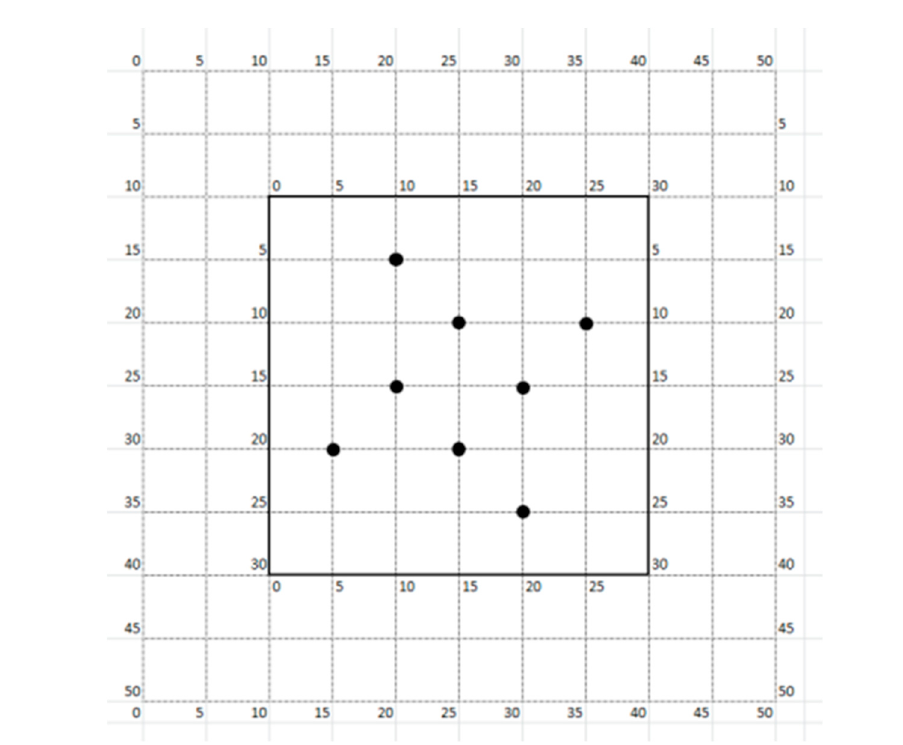
Figure 1. Example of plot design (distances in m) and standard distribution of collectors in the sampling plots